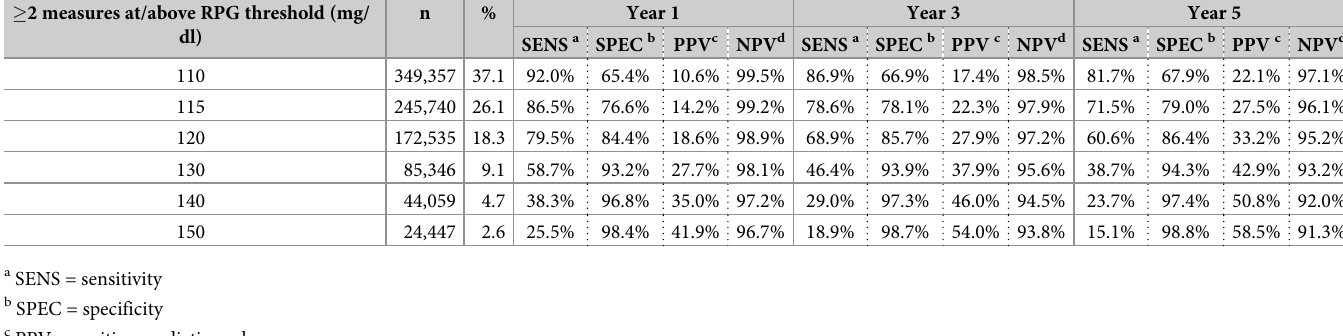
were similar when stratified by sex, except females had a sensitivity and specificity of 80% and 78%, respectively, at a slightly lower RPG threshold of � 110 mg/dl compared to males who Table 3. Sensitivity, sensitivity, specificity, and positive and negative predictive values for different cutoffs for at least 2 RPGs at/above a cutoff to predict a diagno- sis of diabetes within 1, 3, and 5 years. � 2 measures at/above RPG threshold (mg/